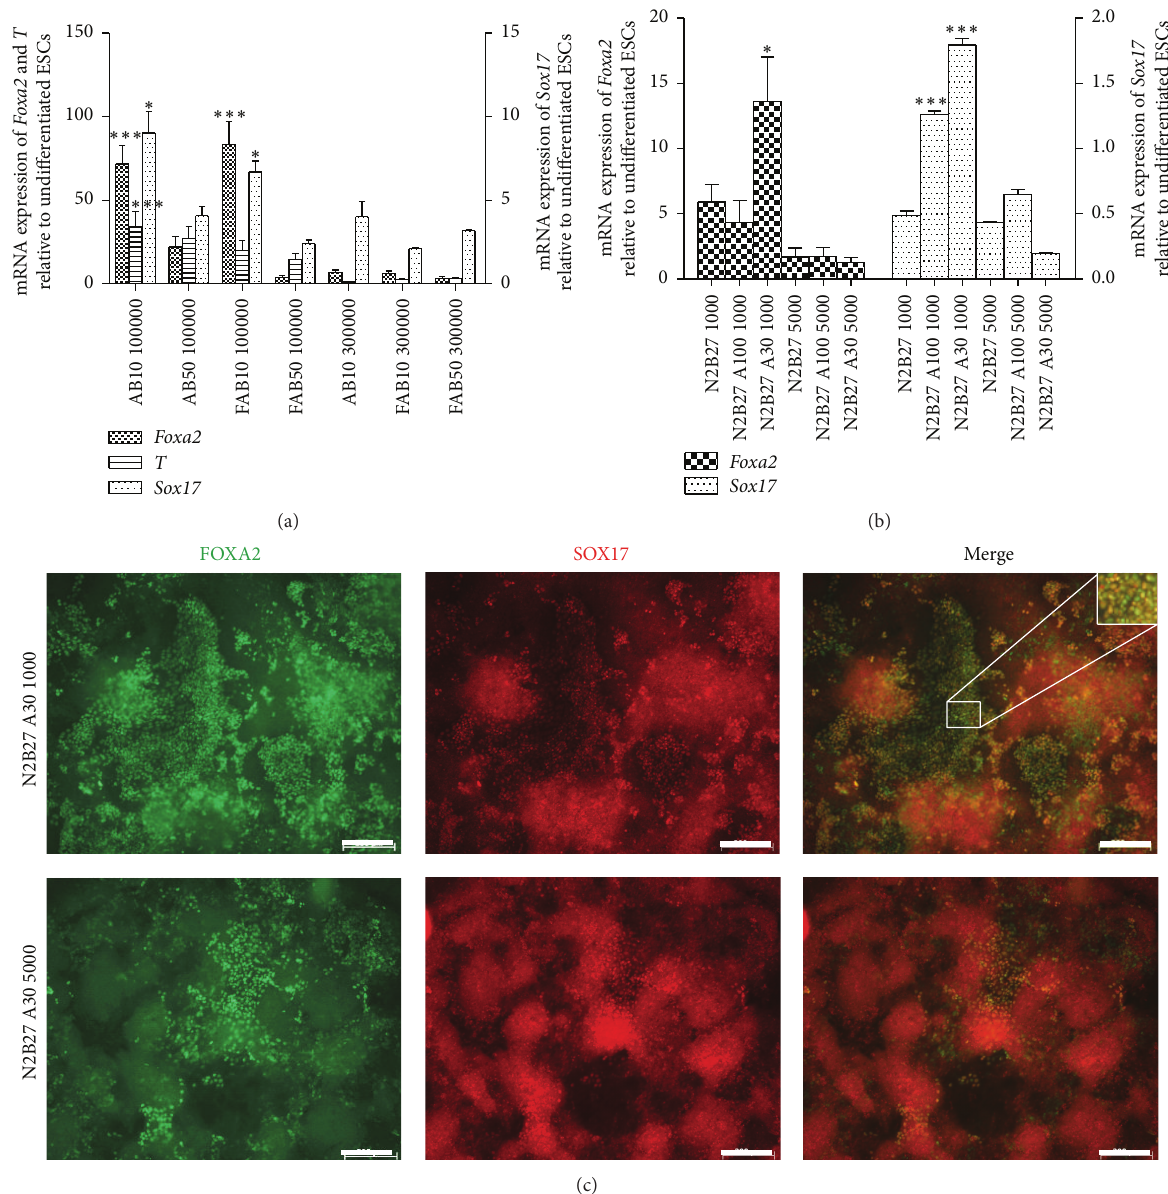
Figure 1: Cell seeding density influences definitive endoderm generation. (a) Cultures seeded with two different mESC densities (100,000 cells/well or 300,000 cells/well of a 24-well plate) were subjected to a 3-day endoderm differentiation protocol containing 100ng/mL bFGF, 100ng/mL Activin A, and 10 ng/mL or 50ng/mL of BMP4. (b) Cells cultured using another endoderm protocol containing Activin A 100ng/mL or 30 ng/mL for 5 days in N2B27 but seeded with two starting cell densities (1000 cells/well or 5,000 cells/well of a 96 well plate). Relative mRNA expression of Sox17 , T , and Foxa2 indicates low densities led to higher expression of DE markers. 𝑁 = 2 . Data are presented as mean ± SEM. Asterisks indicate 𝑃 values on comparison with corresponding high density cultures: ∗ 𝑃 < 0.05 , ∗∗ 𝑃 < 0.01 , and ∗∗∗ 𝑃 < 0.001 determined by one-way ANOVA with Tukey’s multiple comparison test. (c) Immunofluorescent costaining for FOXA2 and SOX17 confirms that cultures that started with low cell density (N2B27 A30 1000) had higher numbers of FOXA2 + SOX17 + definitive endoderm than cultures seeded with high density (N2B27 A30 5000). Images at 5x. Higher magnification inset to indicate coexpression at the cellular level. Scale bars, 200 𝜇